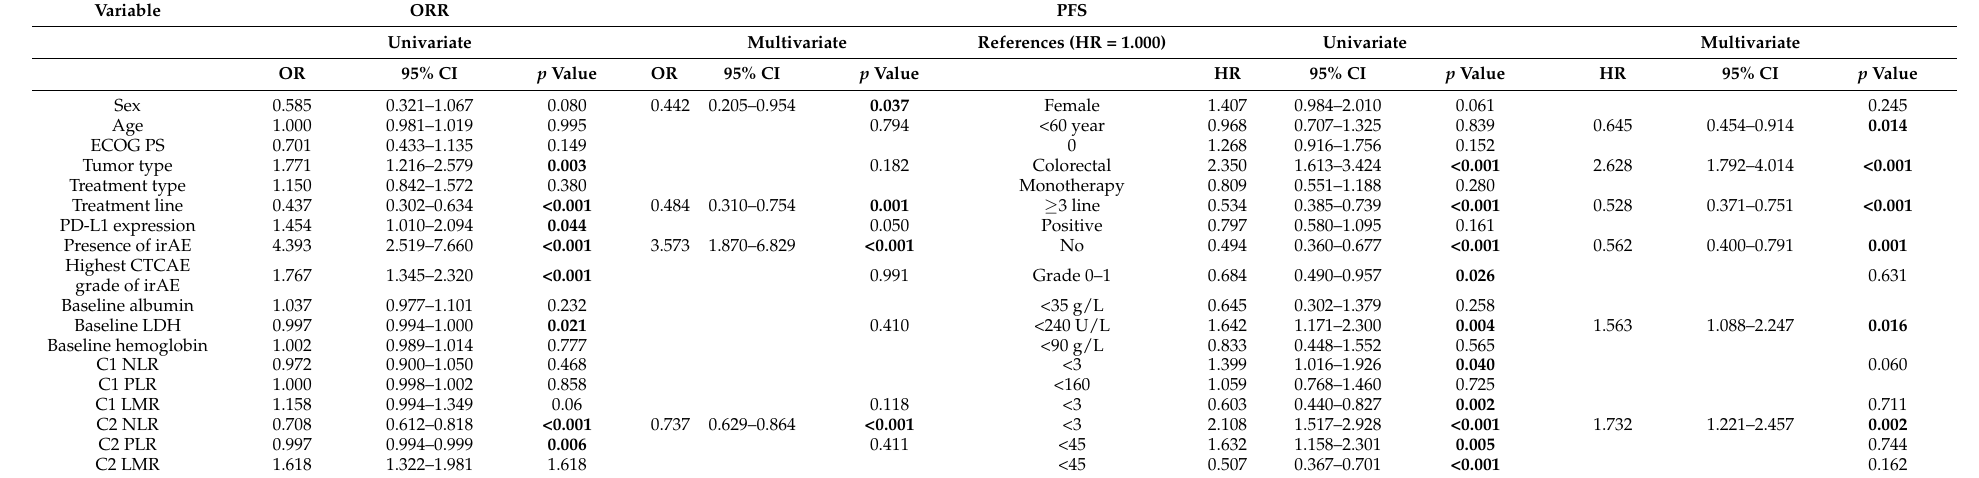
Table 3. Univariate and multivariate analyses of ORR and